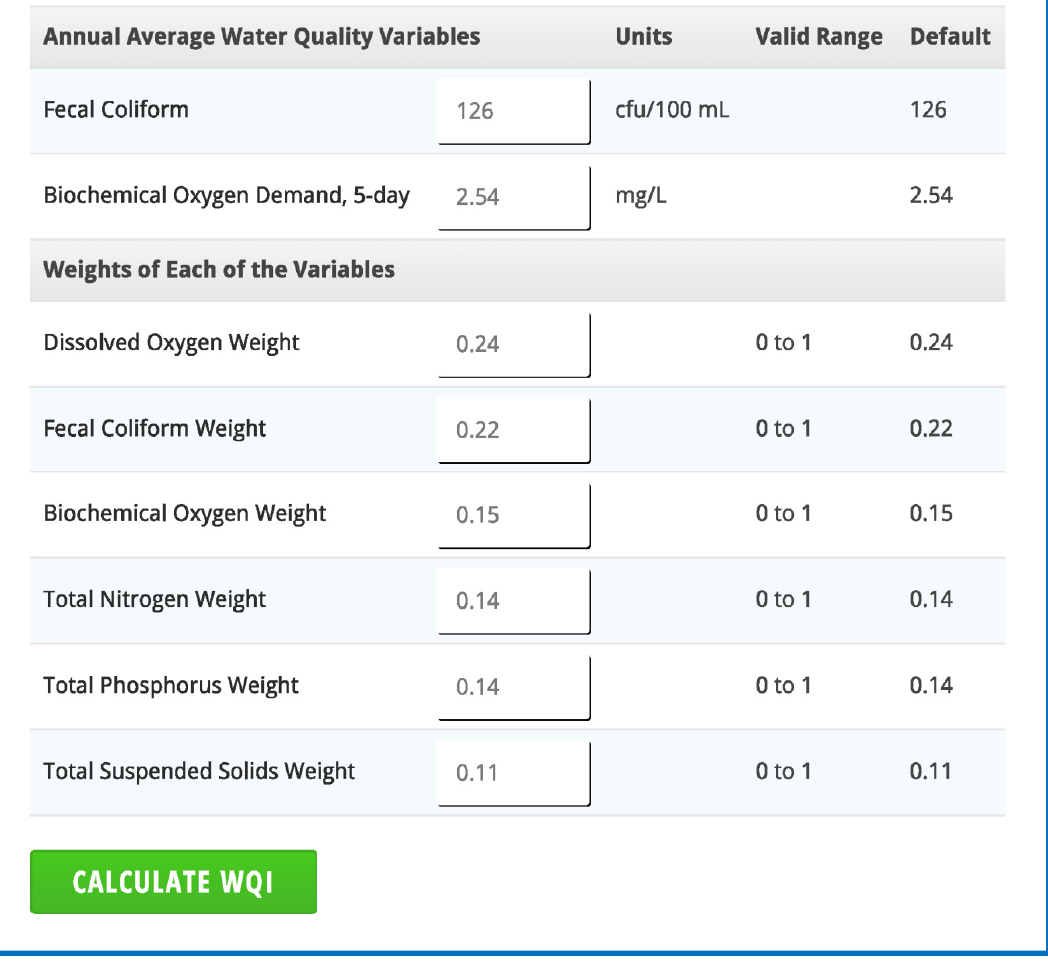
Figure 8. Units and ranges of Water Quality Index (WQI) for eight water quality variables.